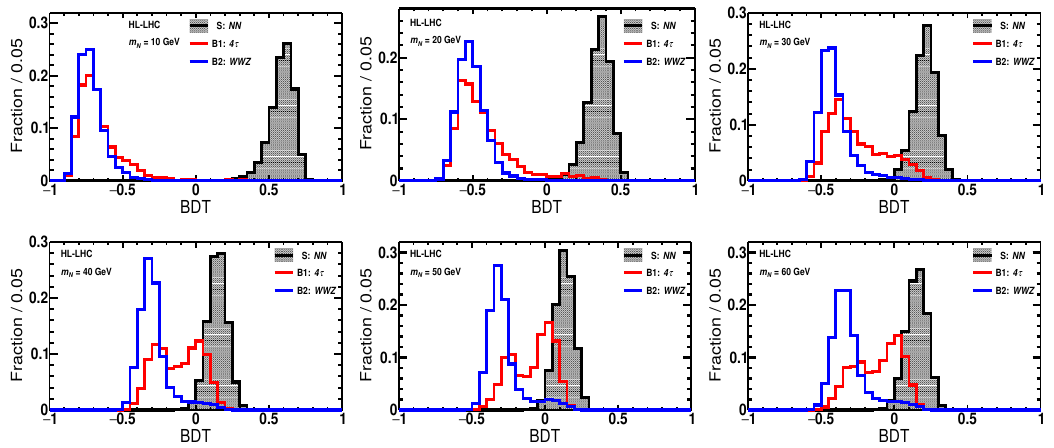
Figure 6 . Distributions of BDT responses for the signal event sample (black, (cid:12)lled), and those for the SM background samples including 4 (cid:28) (red) and WWZ (blue). This (cid:12)gure illustrates an h 1 decay signal by gluon fusion at the HL-LHC, with di(cid:11)erent m N assumptions.